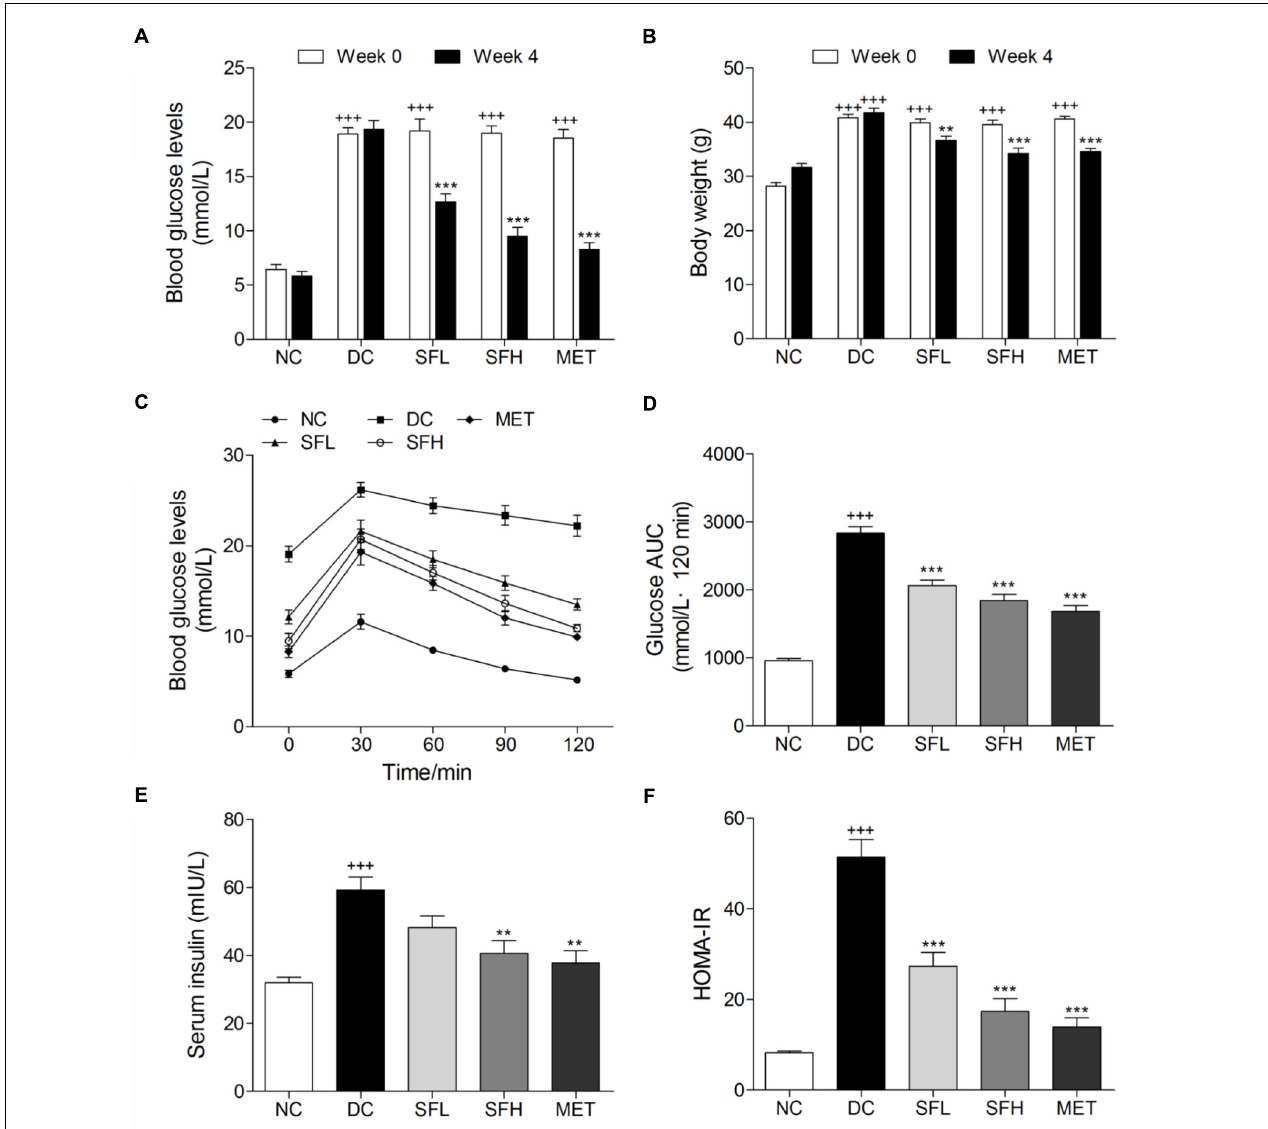
FIGURE 3 | SD-FRE improved glucose metabolism in KK-Ay mice. FBG levels (A) and body weight (B) of KK-Ay mice at 0 and 4 weeks of SD-FRE treatment. Blood glucose levels (C) and AUC of glucose (D) during OGTT. Serum insulin level (E) and values of HOMA-IR in each group (F) . Data are mean ± SEM ( n = 8). +++ p < 0.001 vs. NC group, ∗∗ p < 0.01, ∗∗∗ p < 0.001 vs. DC